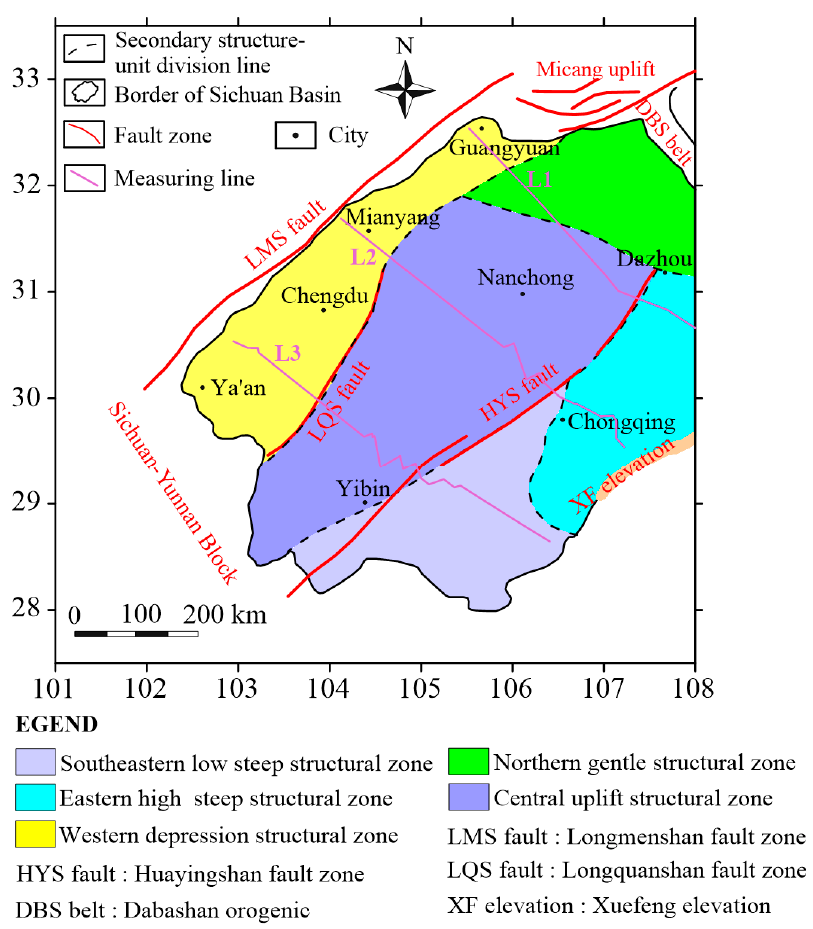
Figure 6. Delineation of tectonic elements of the central and western Sichuan Basin. The central Sichuan uplift area is located east of the Longquan mountain fault zone and west of the Huayingshan fault. It is the most stable central uplift in it, and has maintained highly position since the Sinian period [25]. There are relatively wide and gentle fold structures in the shallow layer of this area, and the number of fractures is small. The deeper the fracture is, the smaller and weaker it is. Previous research [2] has shown that this area presents the characteristics of high resistance, a high–velocity layer and high–density paleostratum. It corresponds to the high–gravity anomaly value and seismic pro fi le L2 protrusion characteristics in this area. It is in a multi–directional extrusion tectonic environment, and the fold–thrust structure around the basin is strongly deformed. It is a foreland depression formed in the western Sichuan Basin since the Late Triassic [26,27]. There are three sets of main structures, which are characterized by nearly east– west trending, nearly north-south trending and northeast–trending, with east–west tilt zoning, north–south trending segmentation and north–south vertical strati fi cation [28]. There is an obvious gravity gradient belt in the Bouguer gravity anomaly map, and it is shown as a high gravity value in the residual gravity anomaly map. The buried depth of the basement is more than 8 km [29], the structure is generally in the northeast direction, the fold amplitude is large, the fault is developed, and there is continuous subsidence after the Indosinian movement. The high and steep area of eastern Sichuan is located southeast of the Huayingshan fault zone. The east boundary is the Xuefeng uplift, dominated by metamorphic basement strata. The northern boundary is the northwestward– southeastward trending South Dabashan arc orogenic belt. In this region, the Bouguer gravity anomaly is high, and several isolated small high–value Bouguer gravity anomaly